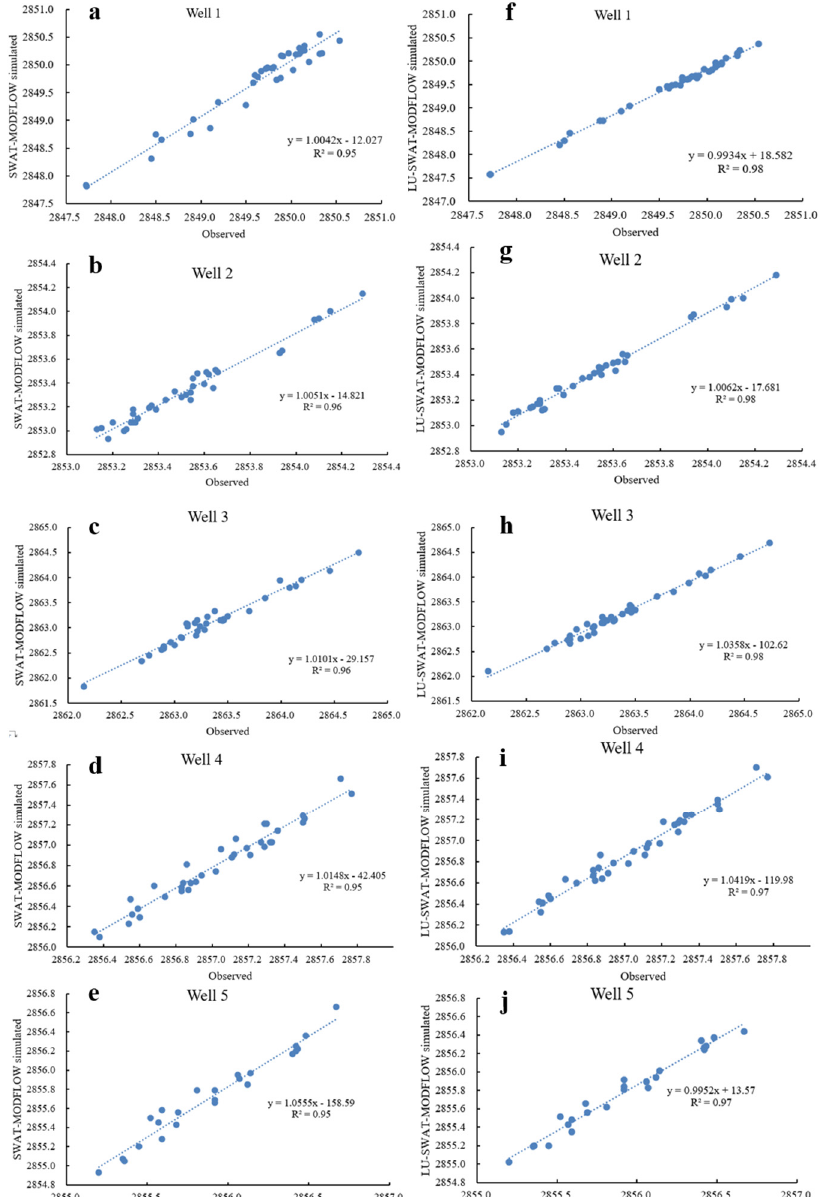
Figure 13. Monthly groundwater table depth simulated by the ( a – e ) SWAT ‐ MODFLOW model ver ‐ sus the ( f – j ) LU ‐ SWAT ‐ MODFLOW